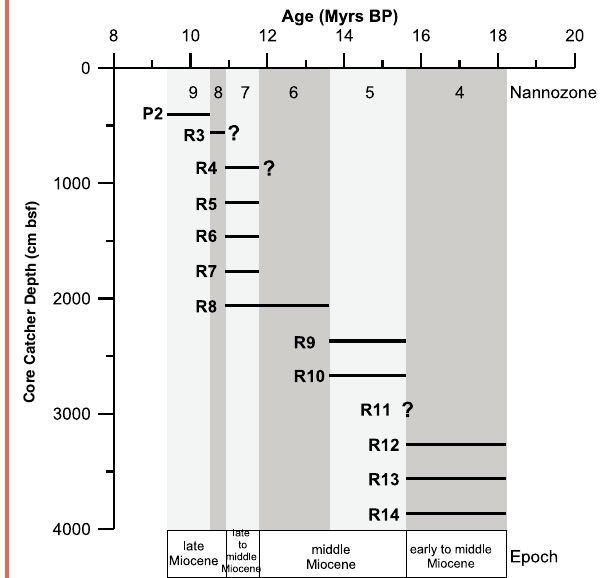
Figure 6. Preliminary shipboard nannofossil stratigraphy by Babette Böckel (unpublished) on core catcher samples at site GeoB11826-1 (26°35N, 14°59W, 1690 m water depth) following the nannofossil zonation established by Martini (1971). Barrel numbers are indicated by P (push coring) and R (rotary